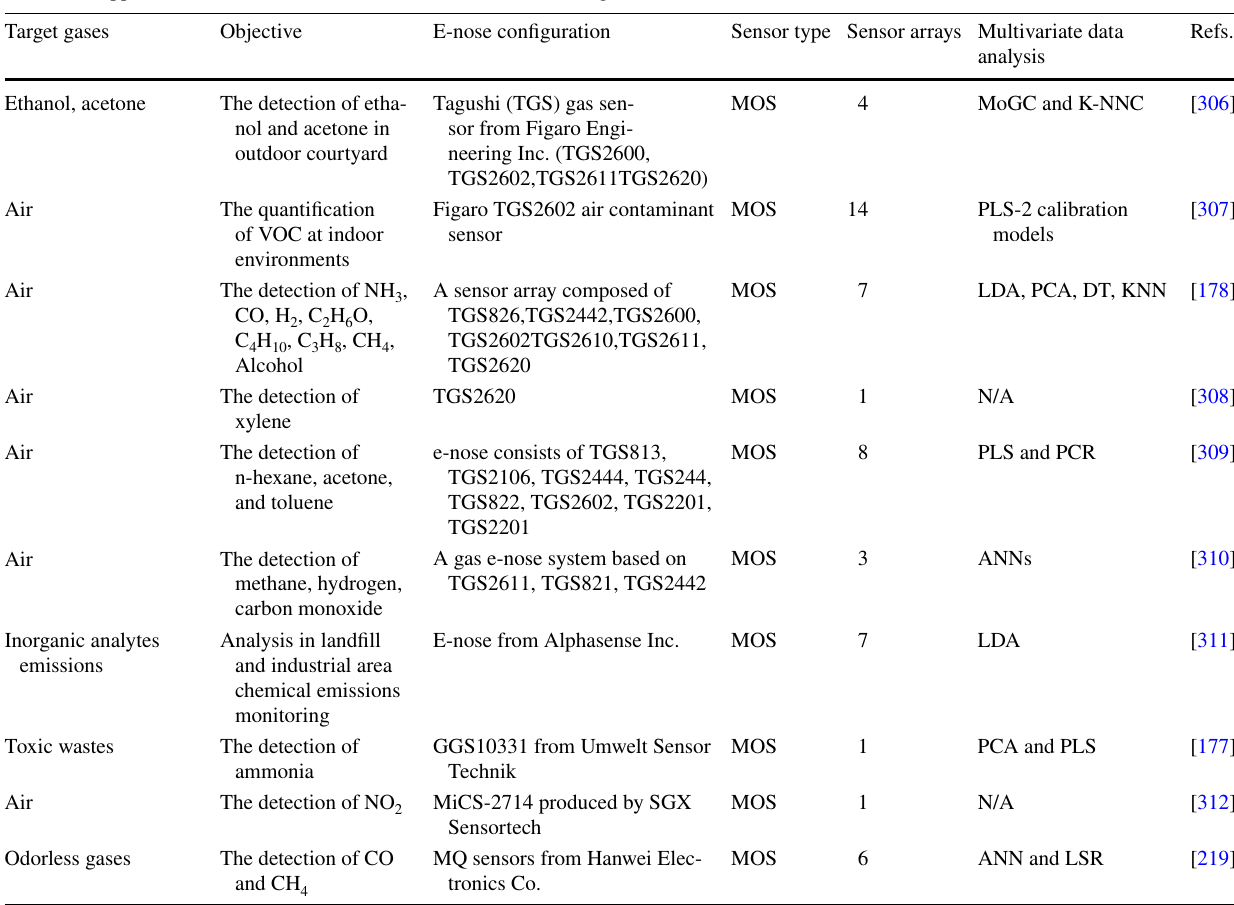
Table 10 Applications of electronic nose in environmental monitoring Target